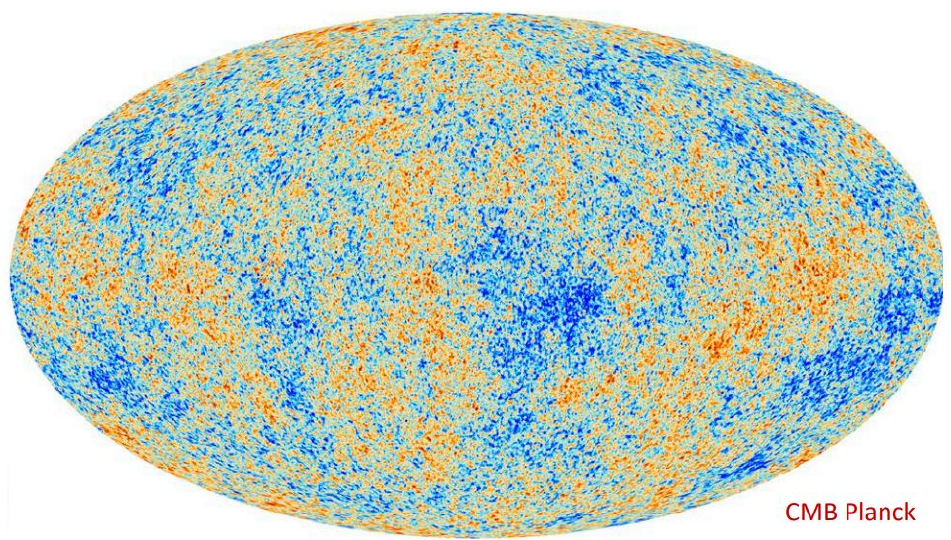
Figure 4. The cosmic microwave background radiation as reported by Planck.